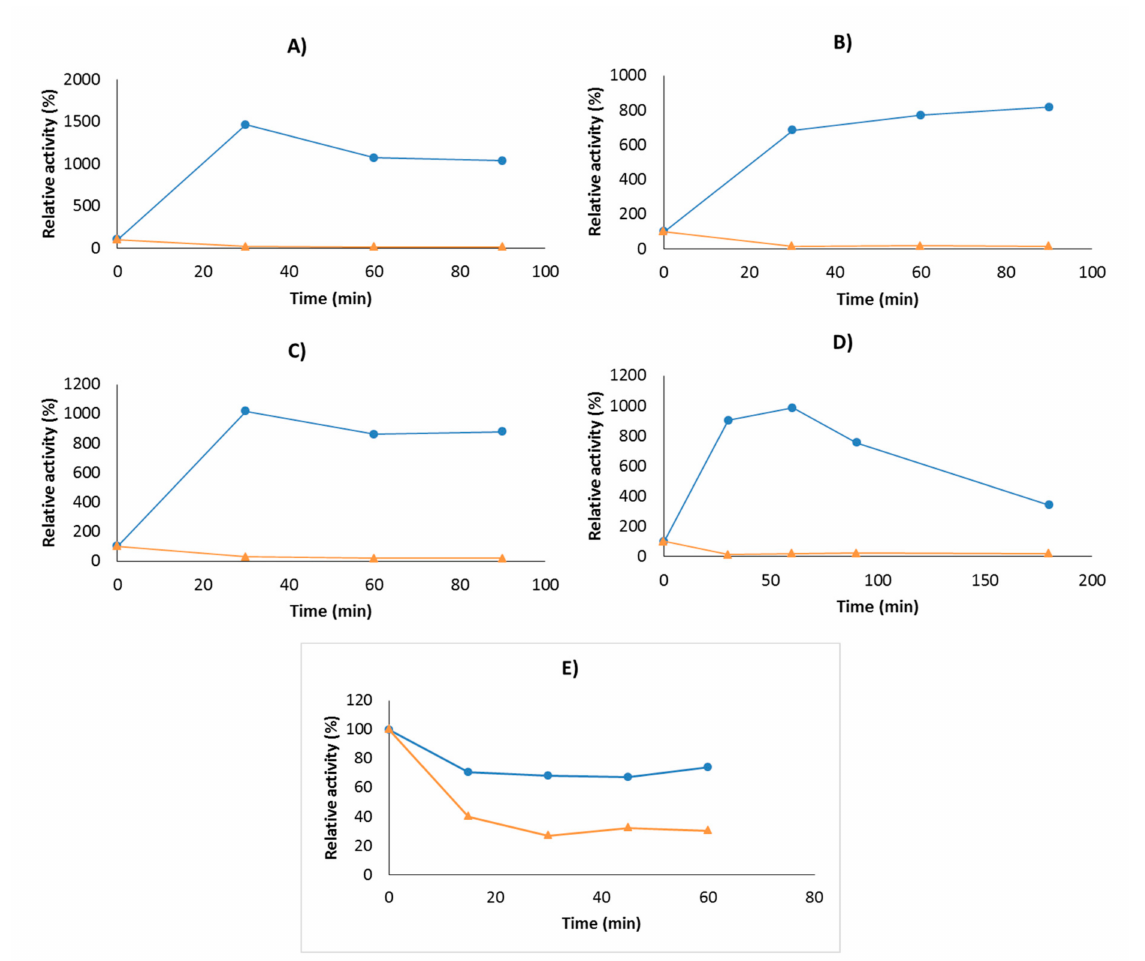
Figure 2. Immobilization courses of USBA-GBX-513 lipase on ( A ) OC-Sepharose; ( B ) OCGLX-Sepharose ( C ) CNBr- Sepharose; ( D ) Q-Sepharose; and ( E ) CALB on OC-Sepharose. The experiments were performed using 1 mg of enzyme/g of support. Other specifications are described in the methods. Orange triangles: supernatant and Blue circles: suspension.